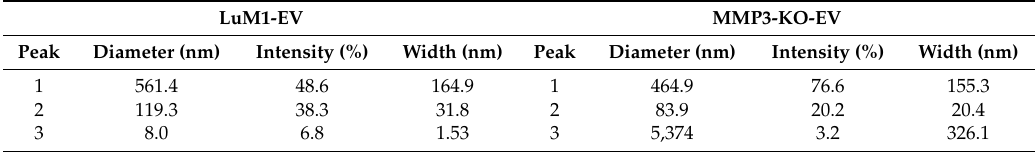
Figure 2. MMP3 knockout impacts the physical integrities of extracellular vesicles. ( A – C ) TEM images of EV fractions derived from the LuM1 and MMP3-KO tumoroids. at ( A ) low magnification, ( B ) high magnification, and of ( C ) aggregated EVs. s-EVs, small EVs; L-EVs, large EVs. Scale bars; 200 nm (in low magnification) and 100 nm (in high magnification). ( D , E ) Representative histograms showing the particle diameter distributions of EVs derived from ( D ) LuM1 tumoroids and ( E ) MMP3-KO tumoroids. The experiments were repeated twice. Table 1. Comparison of particle size distributions between LuM1-EVs and